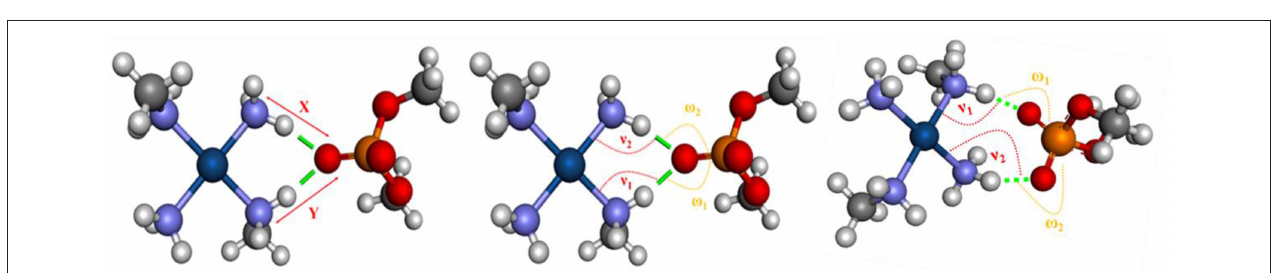
FIGURE 6 | Bond distances and angles analyzed in models. Refer to Table 2 to see the values of x, y, ν 1 , ν 2 , ω 1 , and ω 2 .